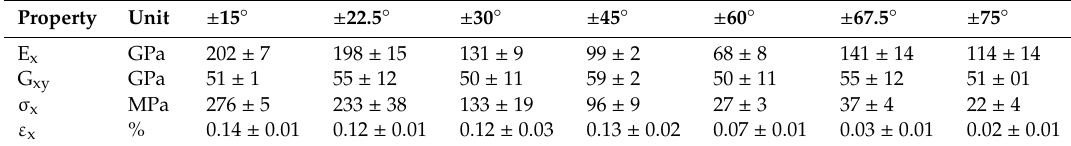
Table 2. Mechanical properties of WHIPOX ™ obtained from tensile and shear tests for di ff erent fiber orientations.